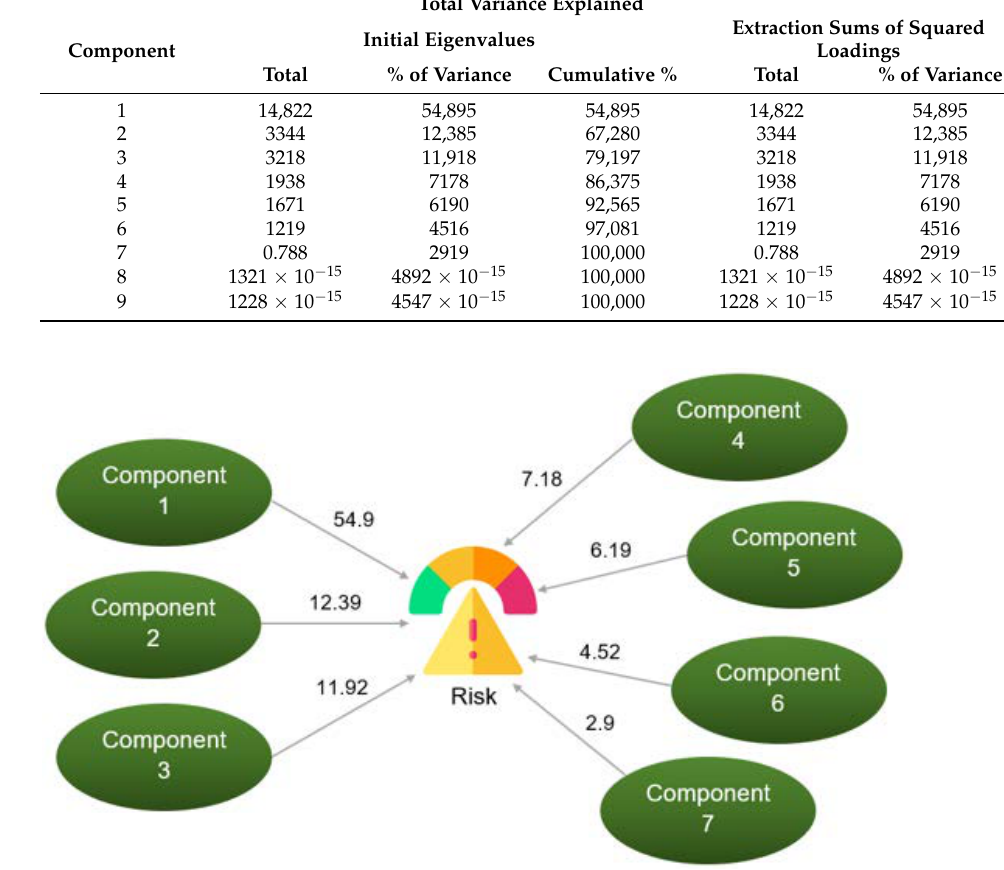
Figure 19. Setup of factorial analysis in SPSS to extract principal components.